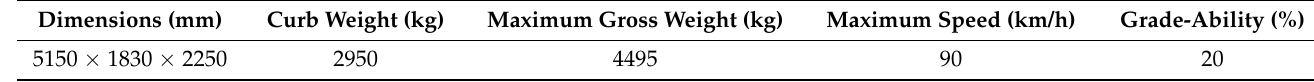
Table 1. Vehicular Parameters of the light truck prototype.